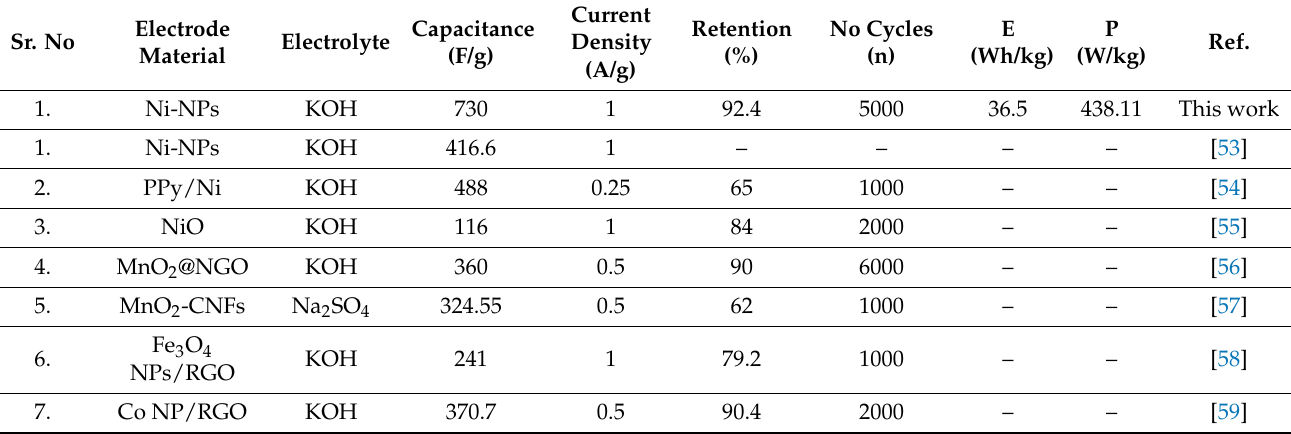
Figure 6. The Nyquist plot was obtained at frequencies ranging from 100 kHz all the way down to 0.01 Hz. Table 1. A comparison of Ni-NP electrode with other already published nanostructured electrode materials for SCs.